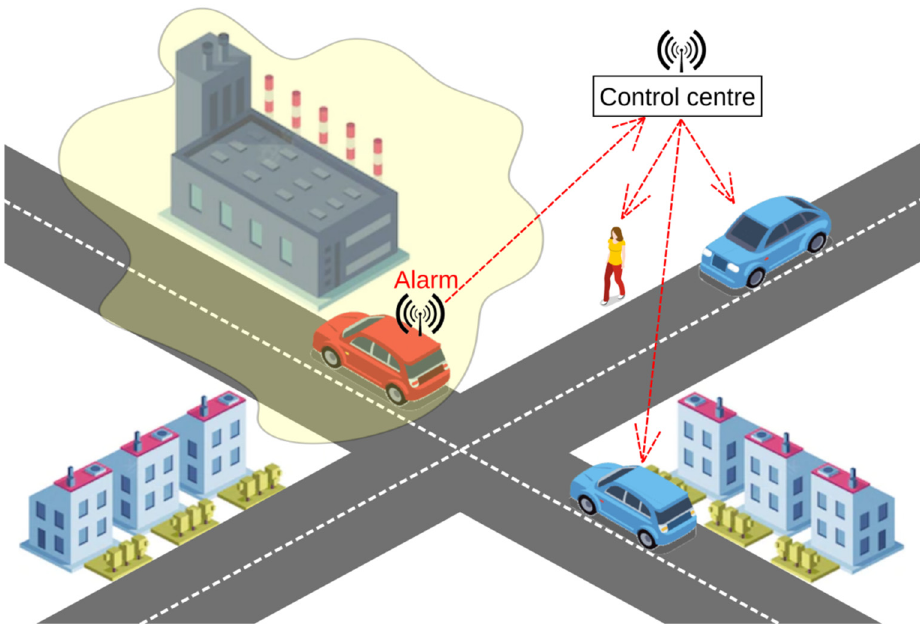
Figure 1. Danger zone detection.